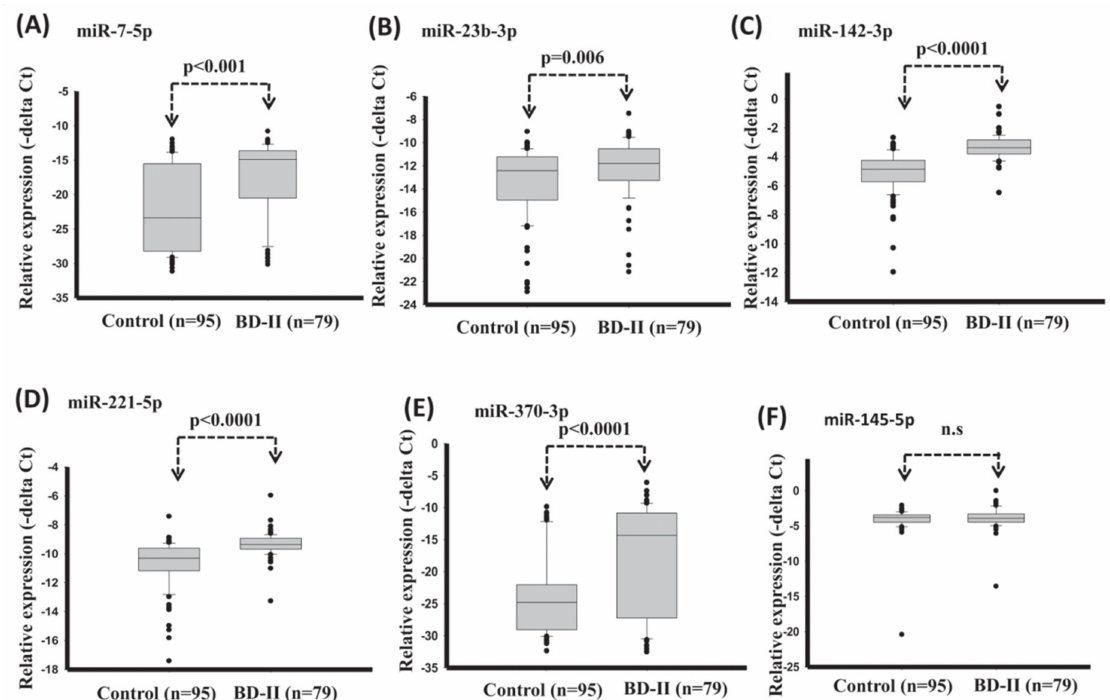
Figure 6. Expression levels of circulating miRNAs in serum in healthy controls and BD-II using t -test (training set). ( A ) miR-7-5p ( B ) miR-23b-3p ( C ) miR-142-3p ( D ) miR-221-5p ( E ) miR-370-3p ( F ) miR-145-5p. (Reproduced with permission from